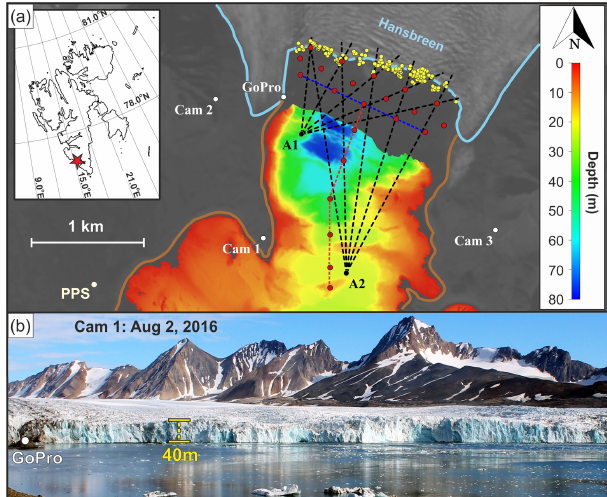
Figure 1. A map of the study site (a) and representative cropped time-lapse image taken by Cam 1 (b) . (a) Locations of time- lapse cameras, acoustic buoys, calving events and CTD casts are marked with white, black, yellow and red dots, respectively. Col- ored, dashed lines show transects of CTD surveys oriented per- pendicular (red) and parallel (blue) to the glacier terminus. Black dashed lines show the spatial arrangement of bathymetry profiles, which we used to model noise transmission losses. Landsat 8 satel- lite data collected on 27 August 2016, courtesy of the US Geo- logical Survey, Department of the Interior. Bathymetric data pro- vided by the Norwegian Hydrographic Service under the permit no. 13/G722, issued by the Institute of Geophysics, Polish Academy of